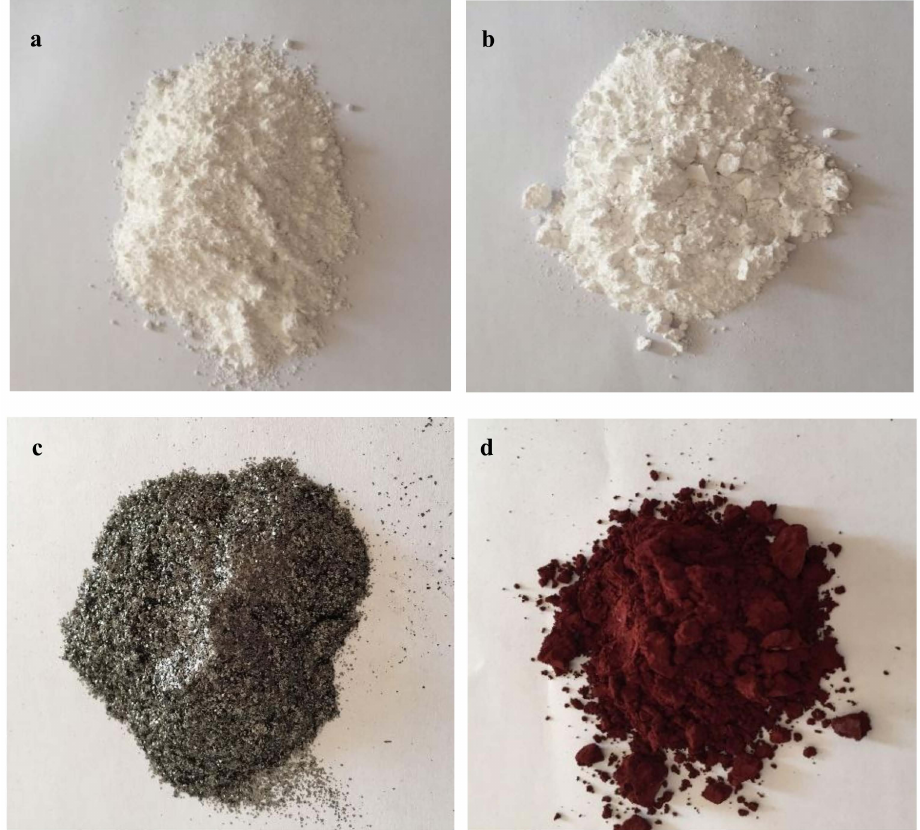
Figure 1. Four fire retardants. ( a ) Aluminum hydroxide; ( b ) magnesium hydroxide; ( c ) expanded graphite; ( d ) encapsulated red